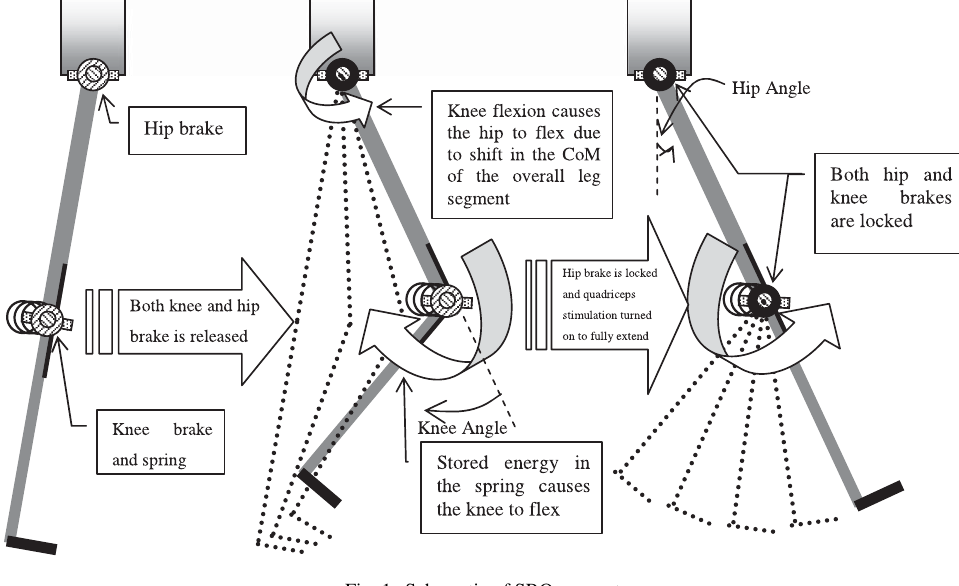
Fig. 1. Schematic of SBO